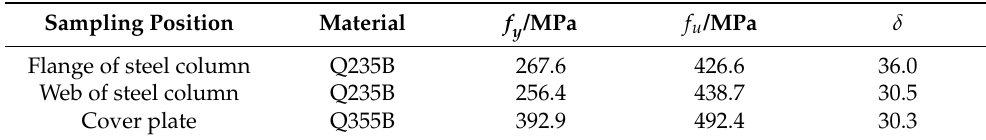
Table 1. Material properties of steel.